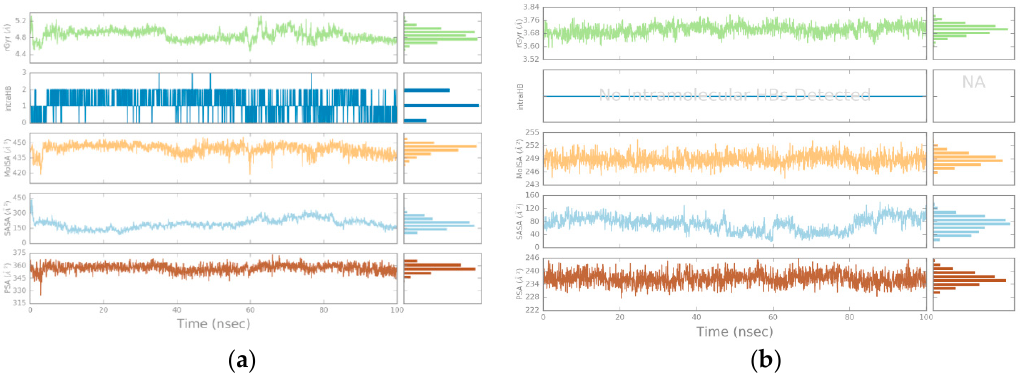
Figure 9. Ligand properties during the 100-ns simulations. ( a ) Amentoflavone; ( b ) Fisetin.